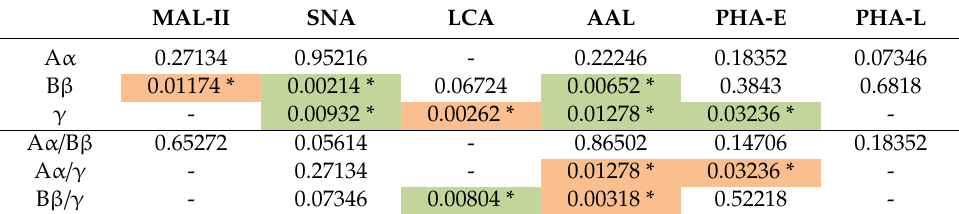
Calculated “ p ” values; statistically significant data are labelled as follows: green color represents decreased in patients on peritoneal dialysis (PD), red color represents increased in patients on PD.